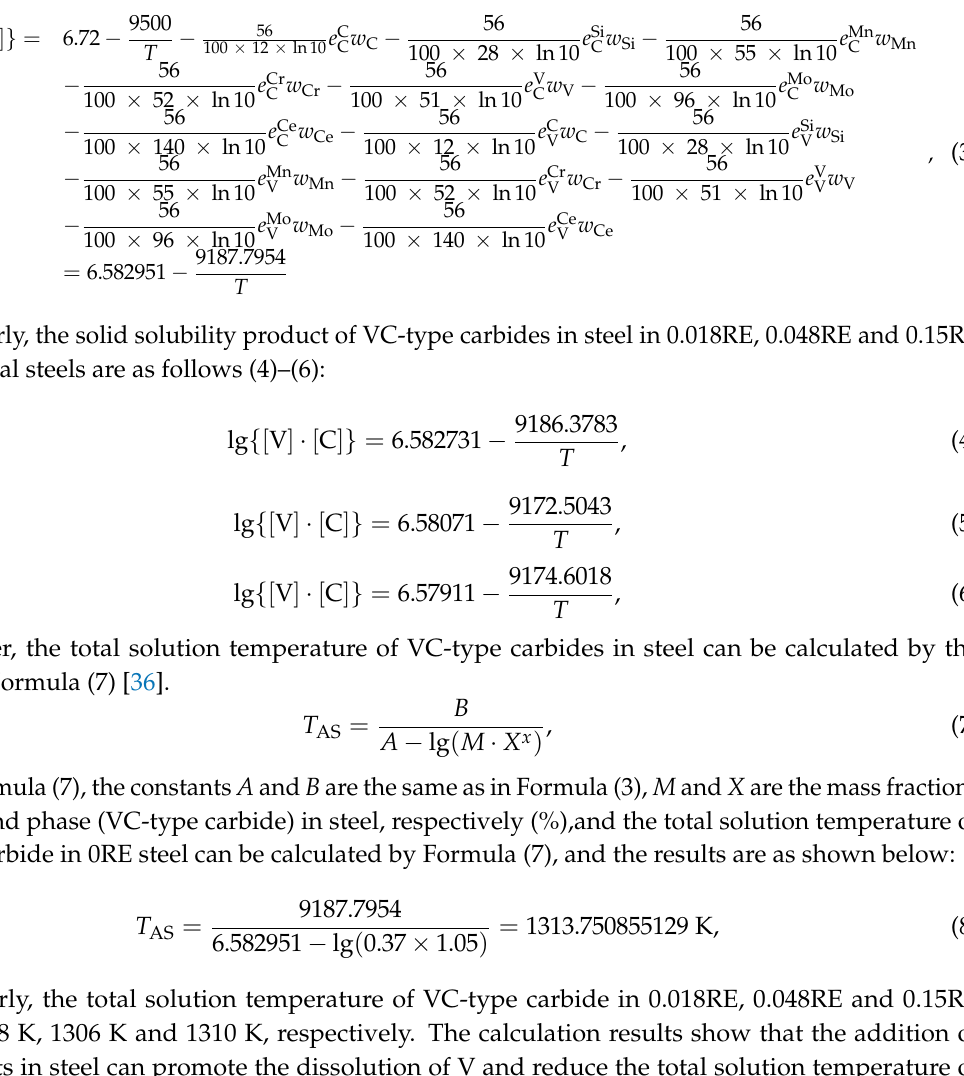
Table 4. Interaction coefficient e j